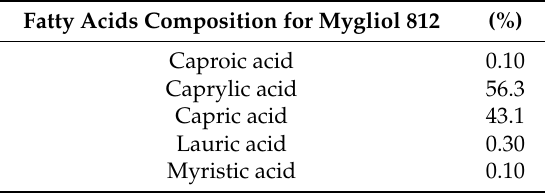
Table 2. Composition of the Mygliol 812 we used in our study. Fatty Acids Composition for Mygliol